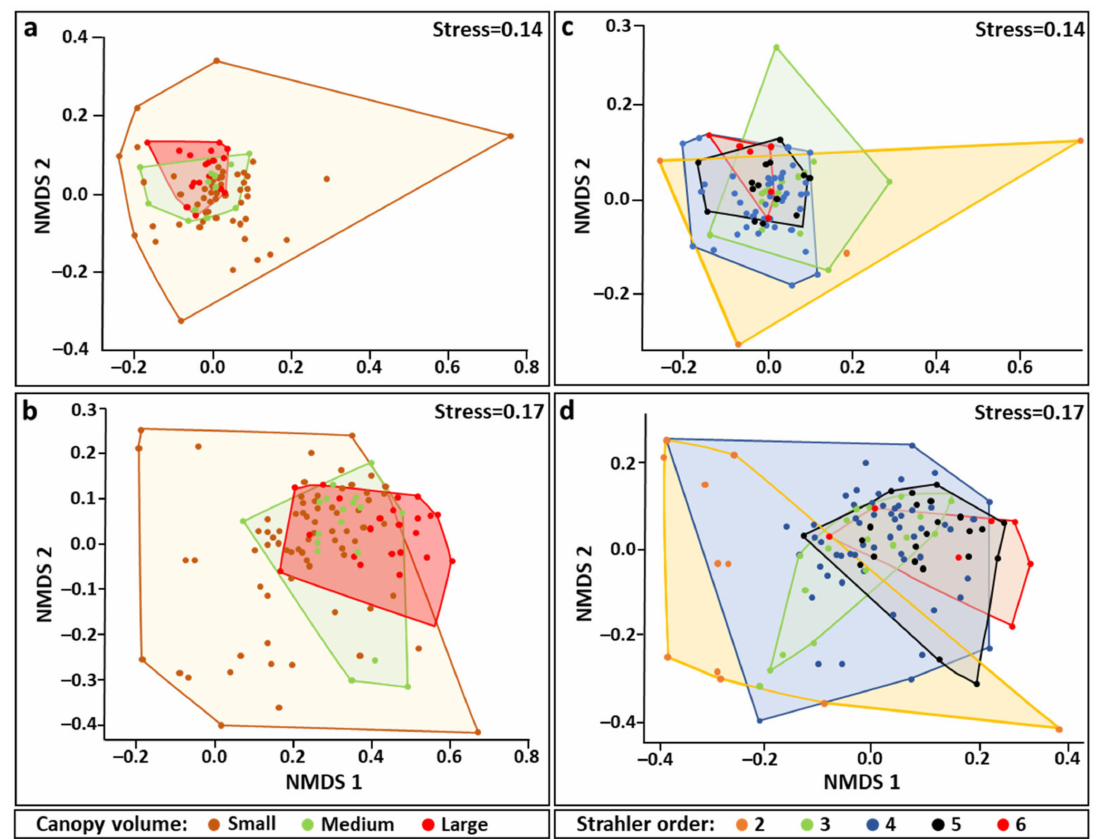
Figure 4. Nonmetric multidimensional scaling ordination plots for Bray–Curtis distance matrix of community dissimilarities based on 0.85 square transformation of S. pistillata dwelling species abundance data. ( a , b ) communities grouped by canopy size (large, medium small) at day and night time, respectively; ( c , d ) communities grouped by canopy Strahler order numbers (2–6) at day and night, respectively. Each canopy community sample is represented by a colored point. 2D stress values are marked for each